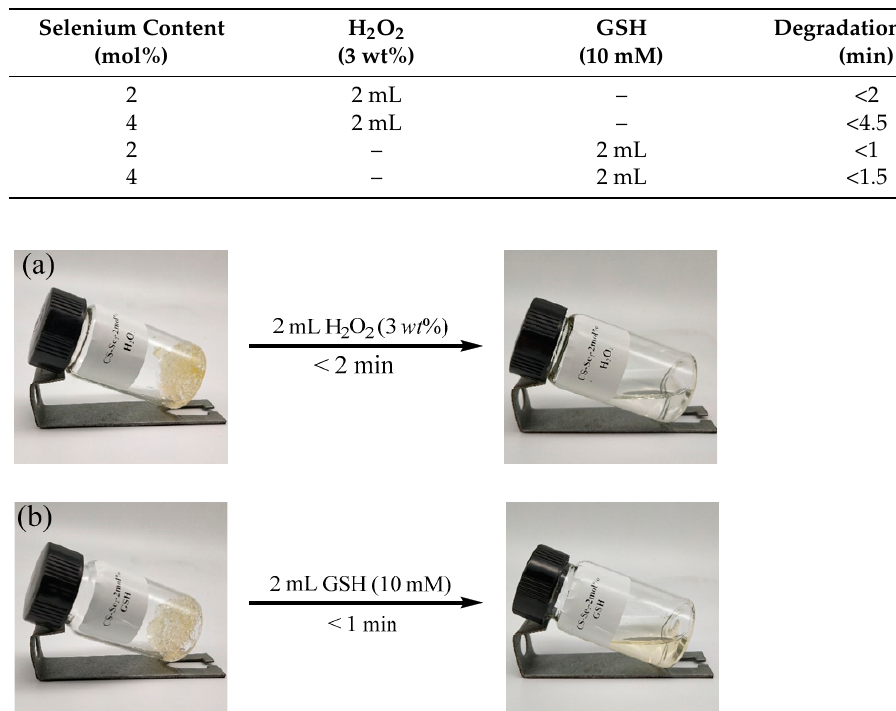
Figure 5. Photographs dissolution of 2 mol% Se-containing chitosan hydrogels samples relying on the oxidation ( a ) and reduction ( b ) of diselenide bonds by H 2 O 2 or GSH, respectively.